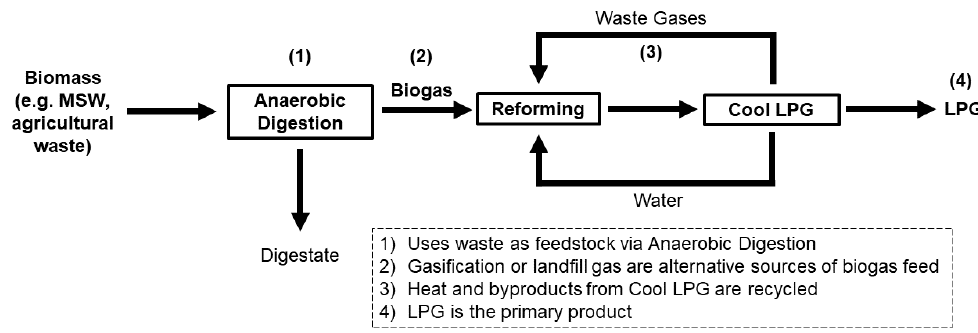
Figure 3. High level Cool LPG process flow.